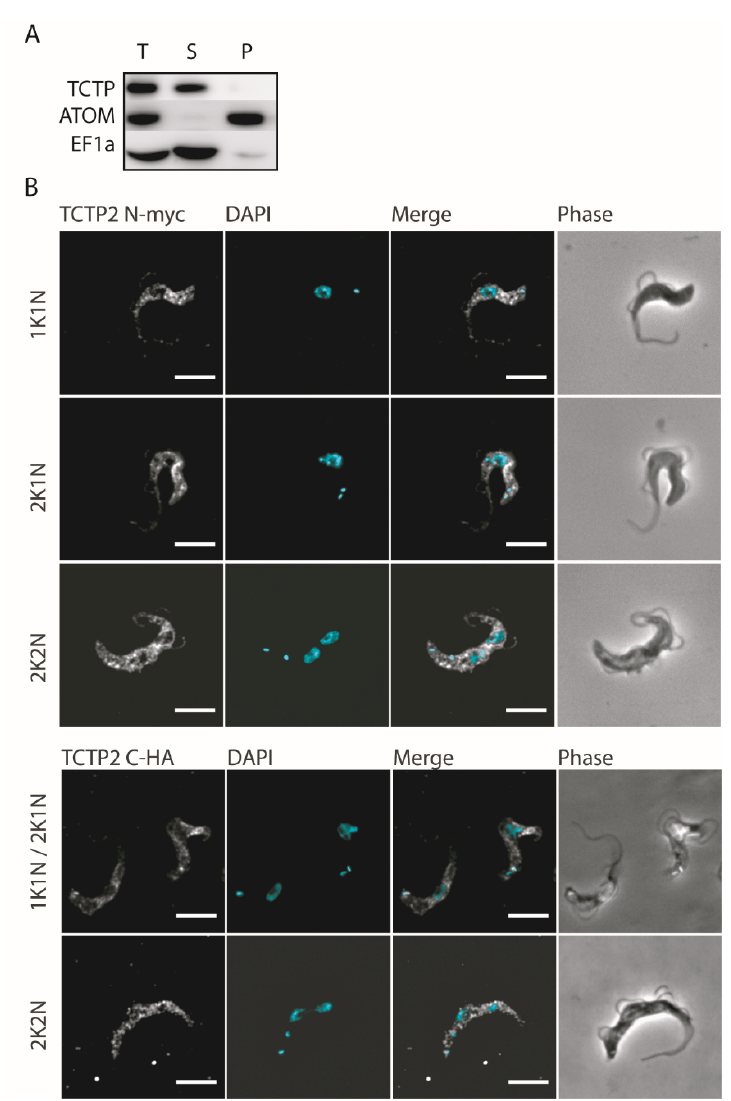
FIGURE 1: Localization of TCTP in bloodstream trypanosomes. (A) Western blot of BSF cells extracted with 0.025% digitonin. Total cellular extract (T), supernatant (S) and pellet (P) fractions were analysed by western blot decorated with antibodies against TCTP, ATOM and EF1α. (B) Immunofluorescence images of BSF cell expressing N-terminally myc-tagged TCTP2 or C-terminal HA-tagged TCTP2. Myc-TCTP2 was de- tected with anti-myc antibody (white). The DNA is detected by DAPI (cyan). K, kinetoplast DNA; N = nuclear DNA; Phase, phase contrast microscopy; scale bars: 5